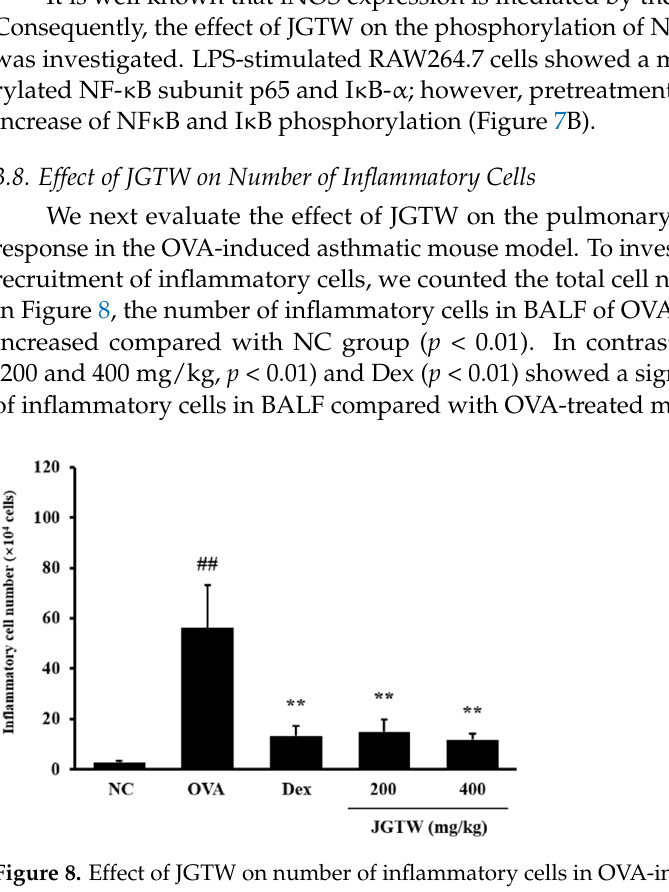
Figure 8. Effect of JGTW on number of inflammatory cells in OVA-induced mice. Number of BALF cell were counted using a light microscope with a hemocytometer. The values are presented as mean ± SEM. ## p < 0.01 versus NC group; and ** p < 0.01 versus OVA-induced group.